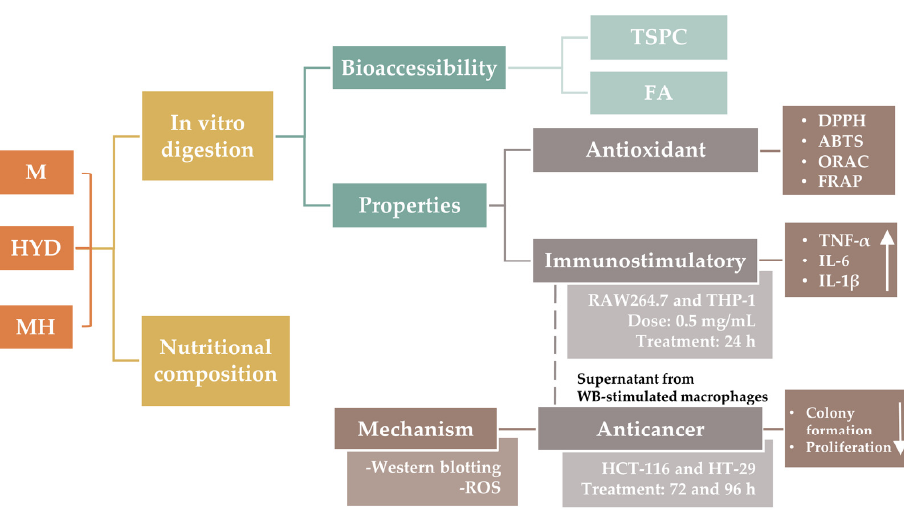
Figure 1. Graphical representation of the experimental design. Abbreviations: control mousse (M); WB hydrolysate (HYD); mousse with WB hydrolysate (MH); total soluble phenolic compounds (TSPC); ferulic acid (FA); 2,2-diphenyl-1-picryl-hydrazyl-hydrate radical scavenging assay (DPPH); 2,2 ′ -azino-bis (3-ethylbenzothiazoline-6-sulfonic acid) radical scavenging assay (ABTS); oxygen radical absorbance capacity (ORAC); ferric reducing antioxidant power (FRAP); tumour necrosis factor (TNF)- α ; interleukin (IL); wheat bran (WB); and reactive oxygen species (ROS).